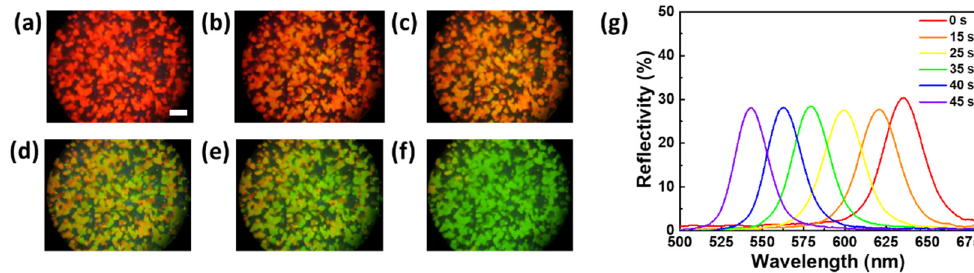
Figure6. R-POMimagesof1.0 wt% -CA-BPLCsamplewithoutsurfacealignmentduringtheillumination of 405 nm laser for ( a ) 0, ( b ) 15, ( c ) 25, ( d ) 35, ( e ) 40, and ( f ) 45 s at BPI. The length of the scale bar is 100 µ m. ( g ) The measured reflection spectra of the corresponding images in ( a – f ). The temperature is fixed at 45.8 ◦ C.